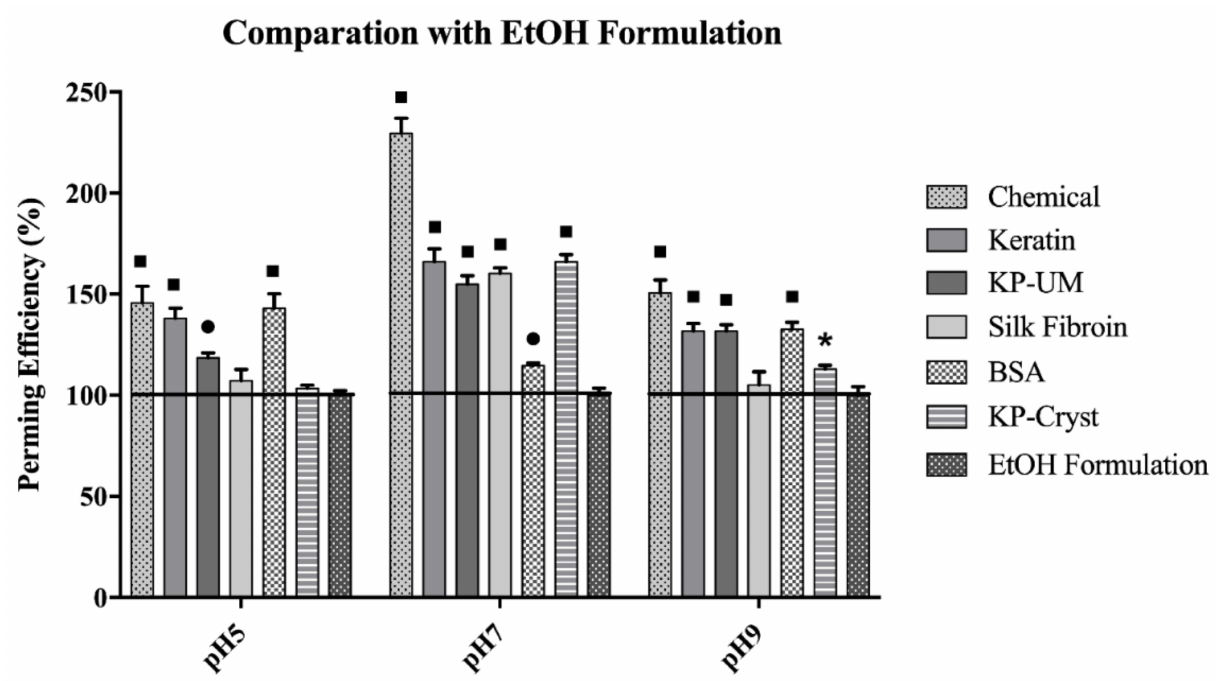
Figure 4. Perming efficiency of the hair treated with the keratin, KP-UM, silk fibroin, BSA and KP-Cryst proteins prepared in phosphate buffer at pH 5, pH 7 or pH 9 compared to the respective “EtOH formulation” sample. Hair treated with a commercial formulation for perming (“Chemical”), treated with the ethanolic formulation and phosphate buffers (“EtOH Formulation”), or without any treatment (“Control”) were used as controls for the proteins’ capacity to curl Asian hair. The values represent the mean ± SD of two measurements. The data were analyzed by Dunnett’s multiple comparison test: p -value ≤ 0.05 (*), p -value ≤ 0.01 ( • ), and p -value ≤ 0.0001 ( (cid:4) ) compared to the respective “EtOH formulation”